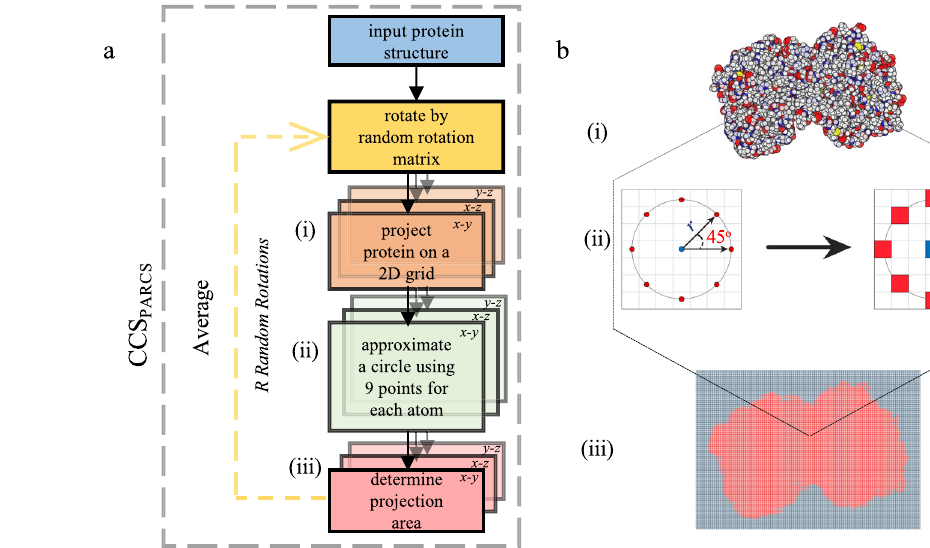
rotation where the carbon, sulfur, oxygen, nitrogen, and hydrogen are colored grey, yellow, red,blue, and white respectively. (ii) Eachatom is projected on a grid with a cell size of 1Å 2 . The center grid cell and eight other grid cells at a distance r (based on the radii of the given atom and the buffer gas) from the center of the atom are fi lled. (iii) Projection of the randomly rotated protein after the grid cells are fi lled according to the PARCS